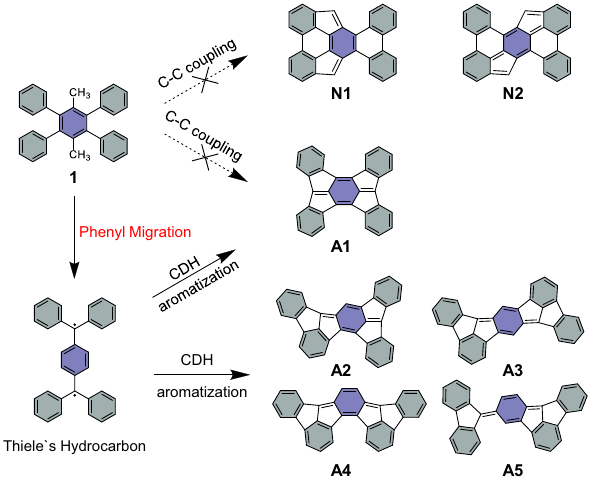
Fig. 1 | On-surface generation of polycyclic aromatic hydrocarbons A1, A2, A3, A4, and A5 via a phenyl group migration reaction in this work. The direct cyclodehydrogenations(CDH)betweenphenylgroupsorphenylgroupandmethyl groups are absent here (no-goproducts N1 and N2 ).The phenyl groups migrate to the para-methyl groups and subsequent cyclodehydrogenation produces A1 , A2 , A3 , A4 ,and A5 .Shadedringswithtwodifferentcolorsmarkthefourphenylgroups and the central benzene,